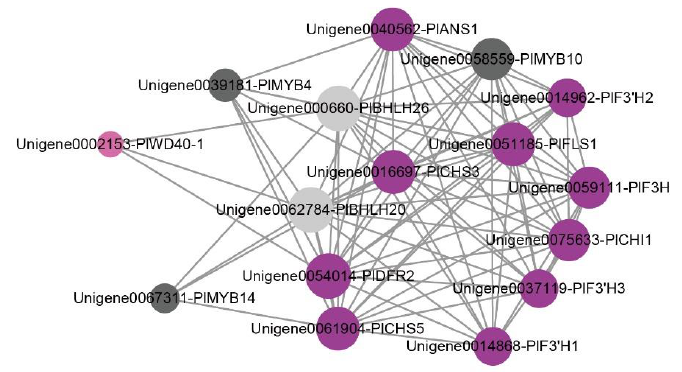
Figure 8. A co-expression network of anthocyanin biosynthesis pathway-related genes and transcription factors involved in pigmentation. Rose-purple circle represents structural genes; dark-gray circle represents R2R3-MYB; light-gray circle represents bHLH; pink circle represents WD40.